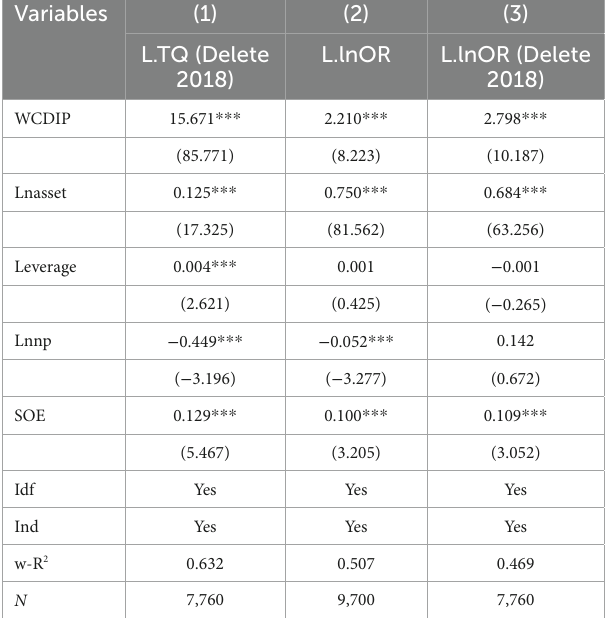
TABLE 5 Robustness test of the impact of WCDIP on MFP.